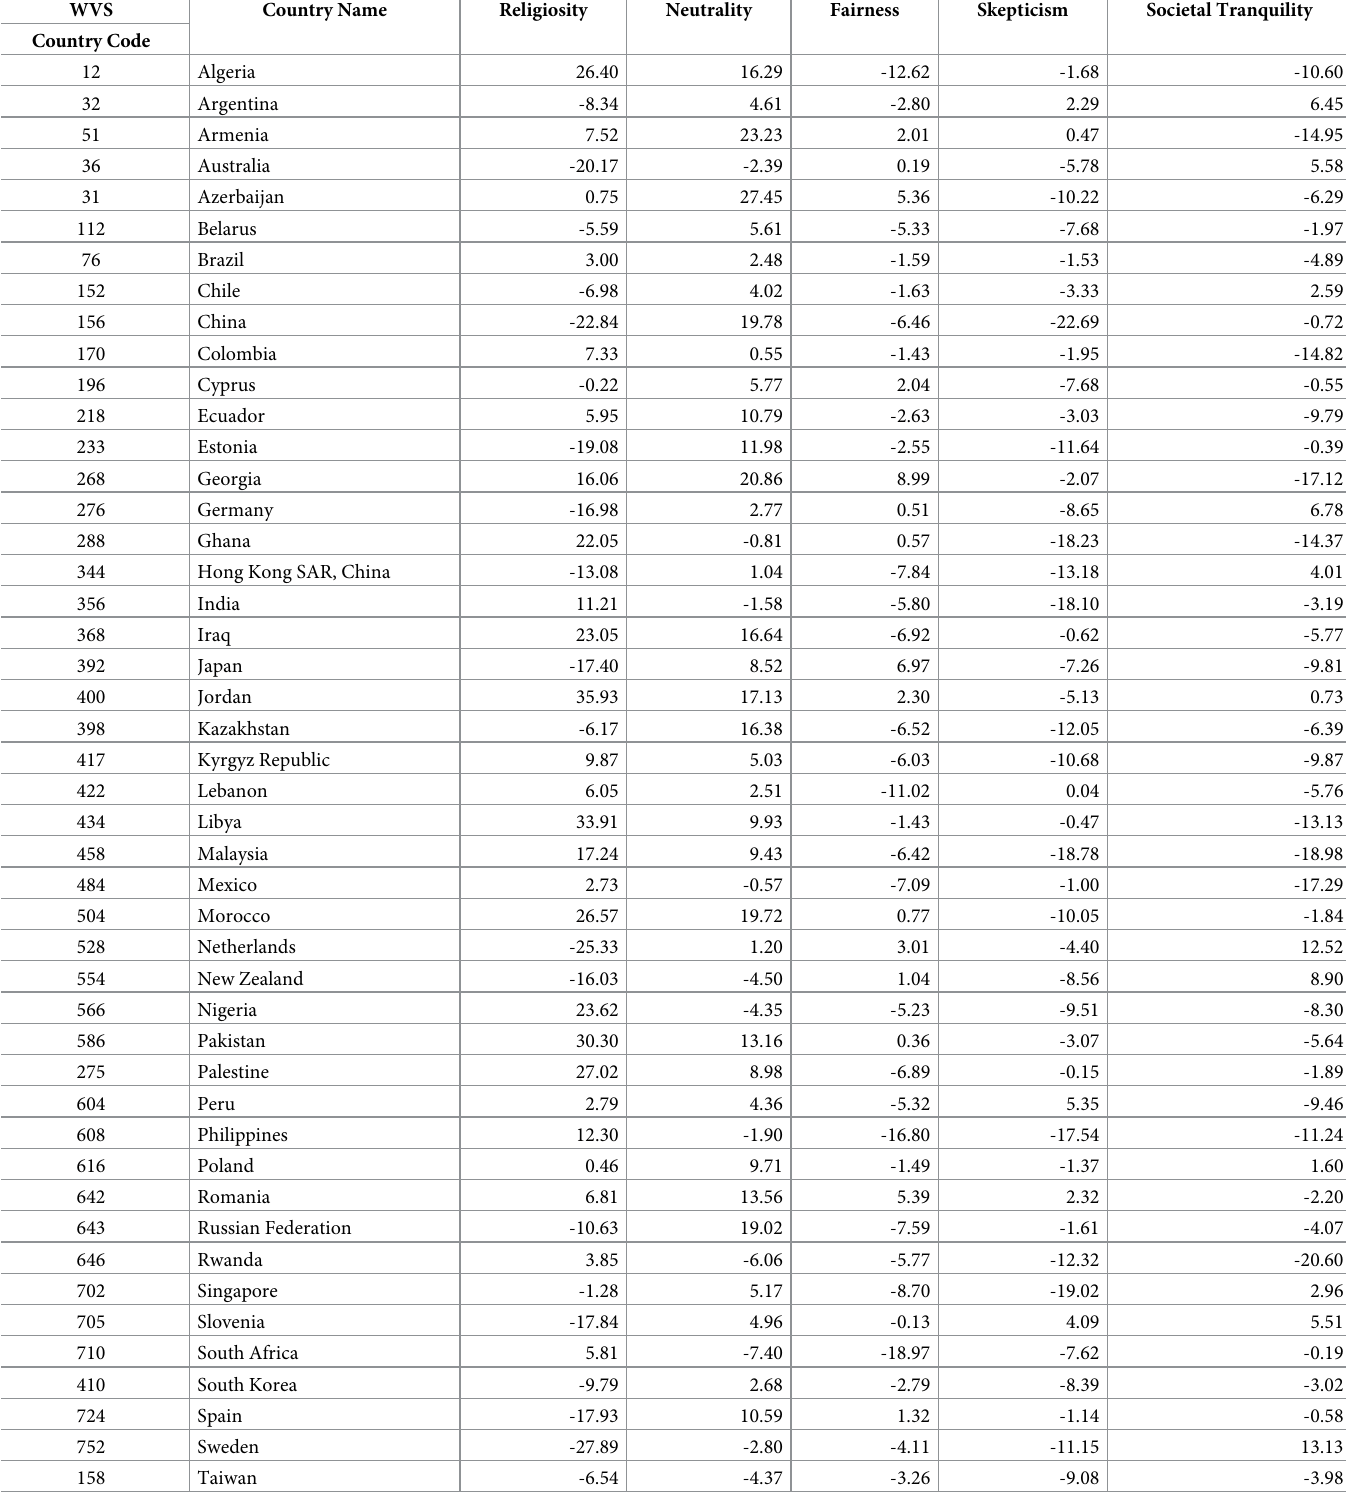
Table 4. Country scores for each social